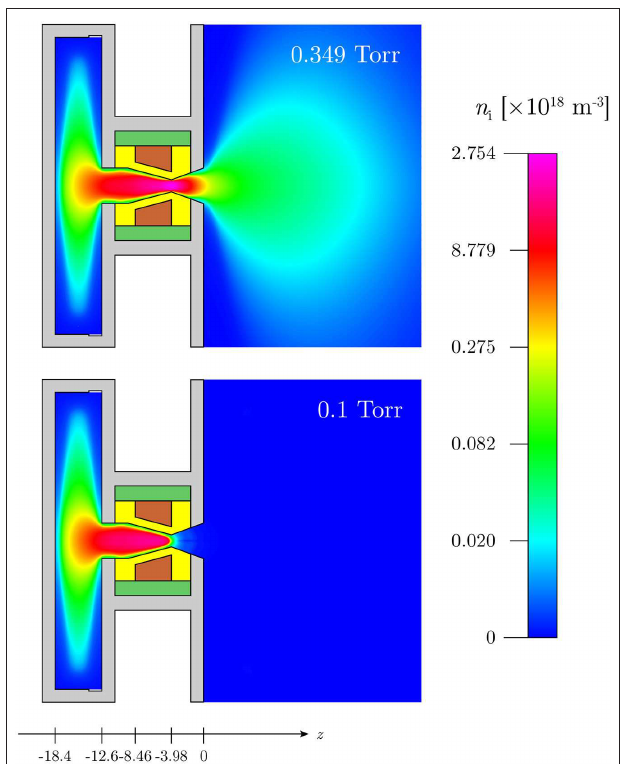
FIGURE 1 | Schematic of the experimental system and CFD-plasma simulation set up showing major components and a 2D color map of the cycle average ion density n i for the 0.349Torr outlet pressure reference simulation (top) and the 0.1Torr outlet pressure DL simulation (bottom) . The color scale is logarithmic with the yellow region of the spectrum representing 1/10 of the full scale. The propellant inlet is the notch in the corner of the plenum, and the flow direction is from left to right. The solid regions are: the discharge chamber wall (yellow, Al2O3), powered RF electrode (brown, Cu), insulation (dark green, Macor), and structure (gray,